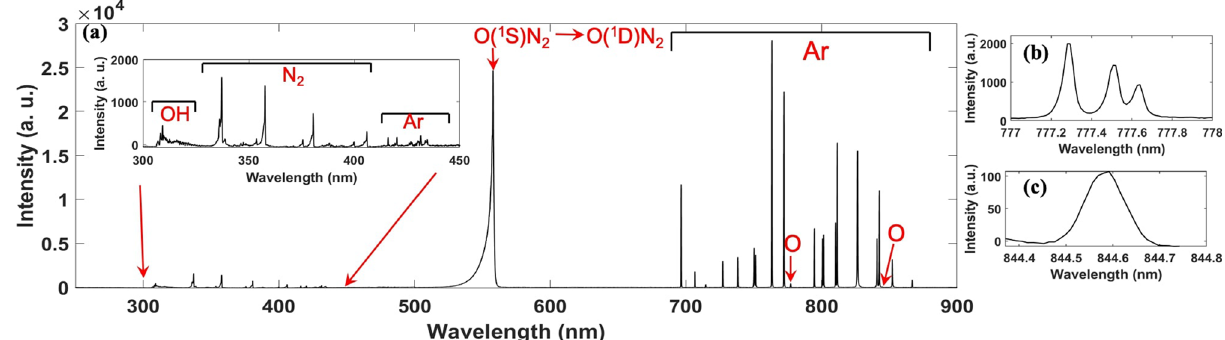
Figure 3. ( a ) Emission spectra from 250 nm to 900 nm observed in the APPJ ( V d = 10.8kV , f = 21kHz , = 6 sL/min , electrode gap = 40mm ). ( b ) High resolution spectra of the oxygen triplet at 777 nm. ( c ) High Q Ar resolution spectra of oxygen at 844.6